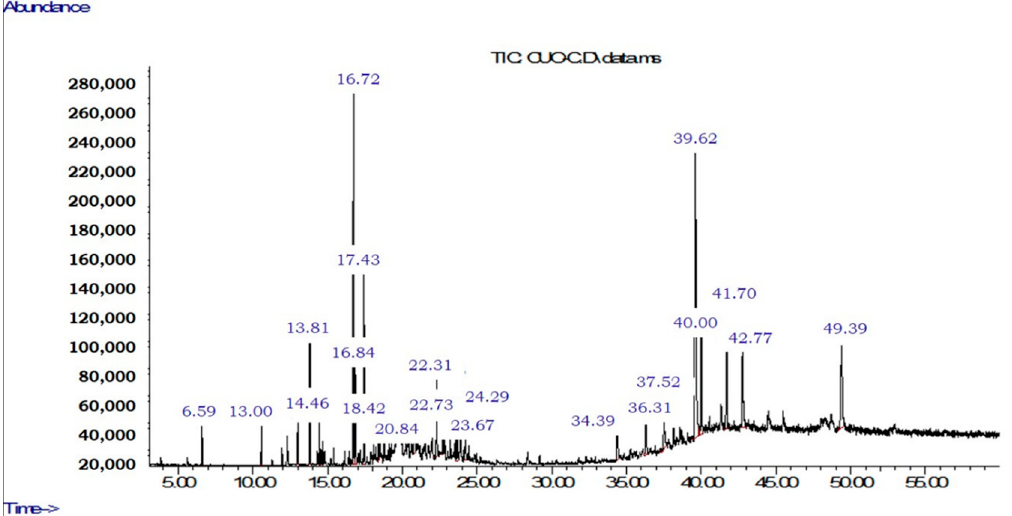
Figure A4. Dipteryx punctata branches extract chromatogram.